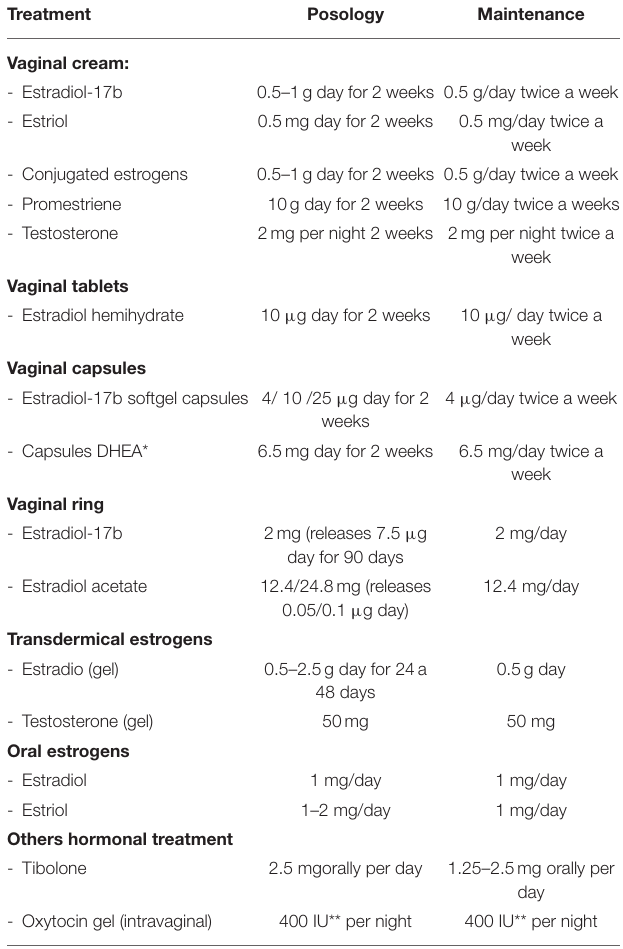
TABLE 1 | Hormonal therapy options.